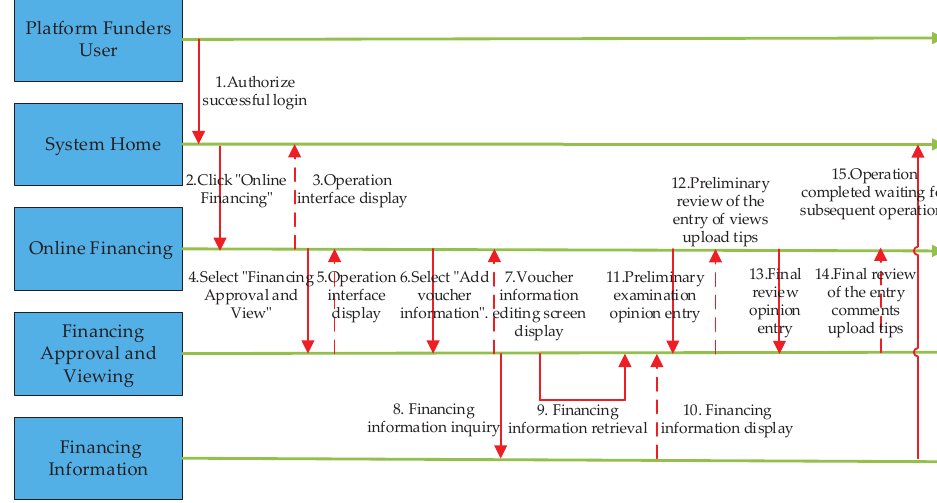
Figure 5. Financial approval and viewing operational schedule